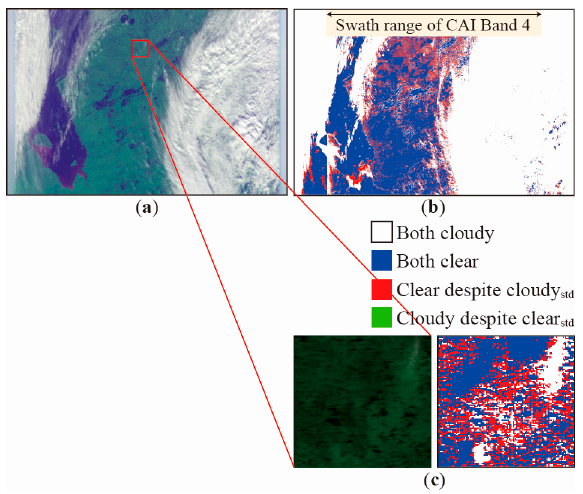
Figure 8. Comparative results for Canada on 1 October 2012. ( a ) Input CAI L1B product (R: Band 2, G: Band 3, B: Band 1); ( b ) Comparative results using SV generated by Procedures 1 and 2 when using the SV generated by Procedure 1 as a standard; ( c ) Enlarged figures of ( a ) and ( b ).